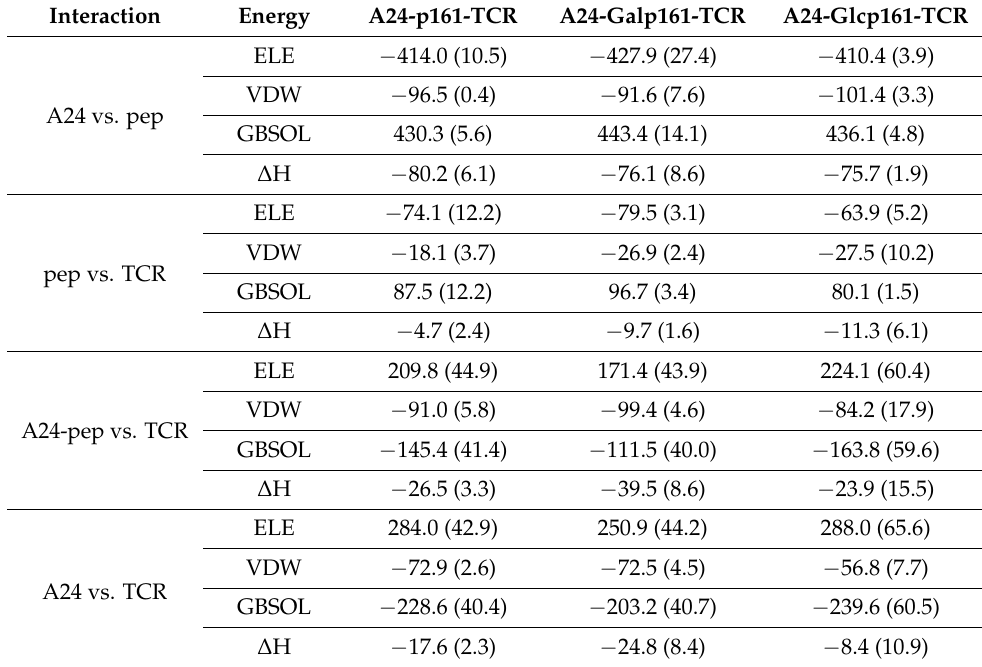
Table 4. Binding energies ∆ H GBSA during the last 200 ns of the MD simulations of the ternary A24-peptide-TCR complexes. All the values are in kcal mol − 1 and the standard deviations are in